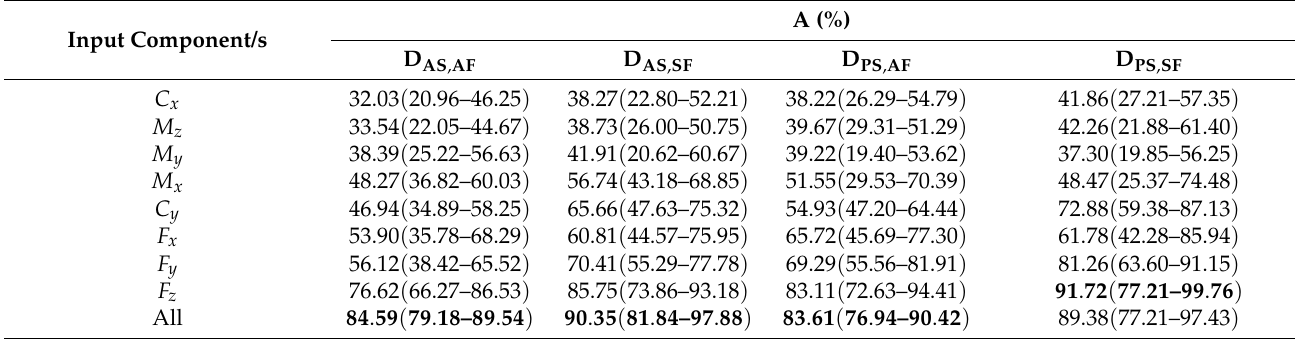
Table 5. Accuracy (A) across all models with different inputs (provided as mean and min–max range over test sets with the best results in